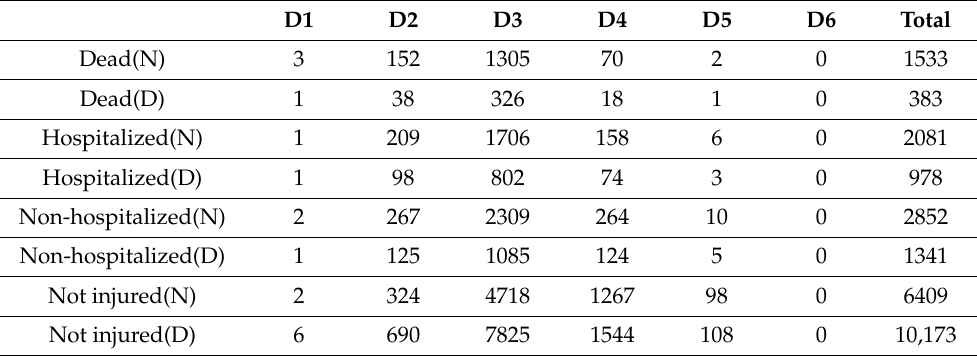
Table 27. Number of casualties in the 1780 earthquake in District 8 of